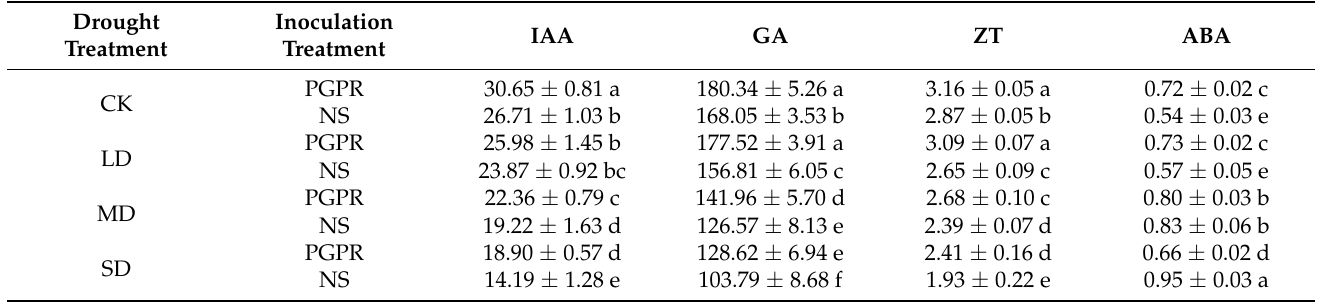
Table 3. Effects of different drought and inoculation treatments on the content of different endogenous hormones in the leaves of walnut seedlings (Mean ± SD).